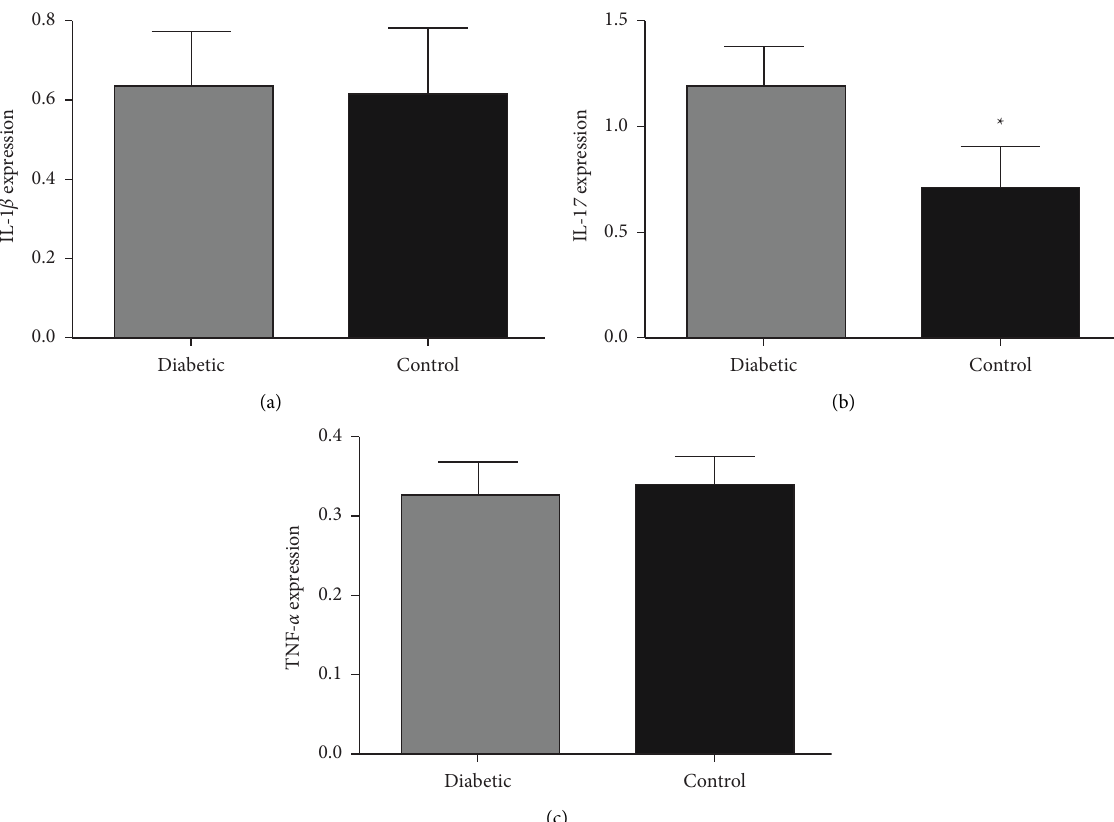
Figure 2: Comparison between the proinfammatory cytokines expressions in periradicular lesions of diabetic patients with control patients (Mann–Whitney test). (a) IL-1 β , (b) IL-17, and (c) TNF- α . ∗ p < 0 .